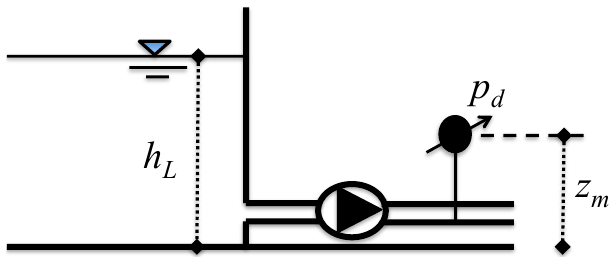
Figure 2. Scheme of the pump setup installation.